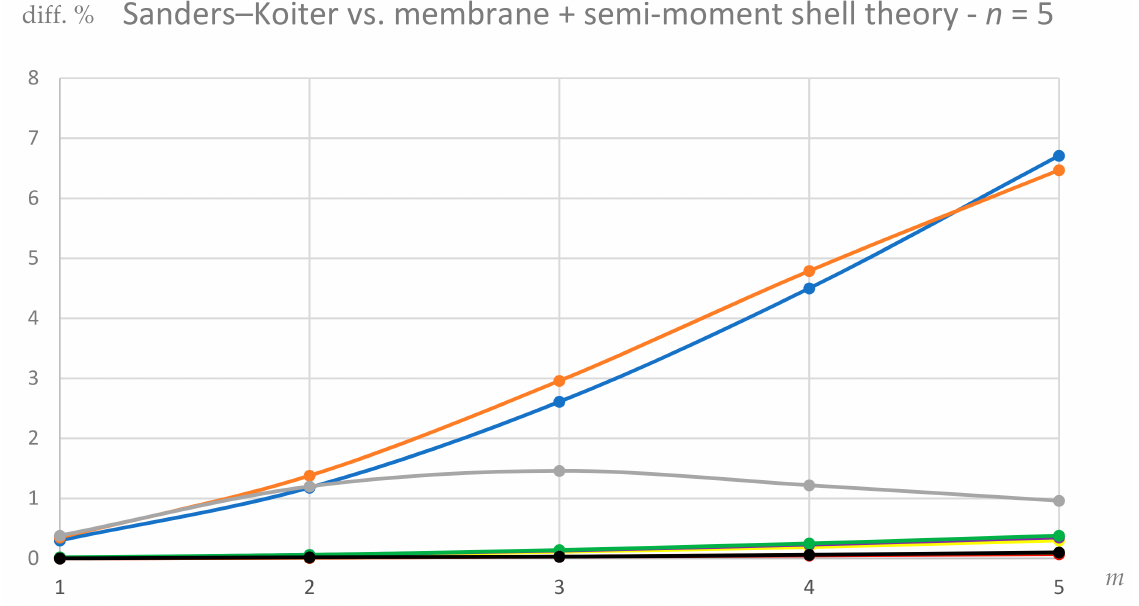
Figure 15. Simply supported DWCNT of Table 1 with different values of aspect ratio L / R 2 and thickness ratio R 2 / h . Shell-like modes ( n = 5). Comparisons between extended Sanders–Koiter and membrane + semi-moment shell theory, where L / R 2 = 10, R 2 / h = 25;